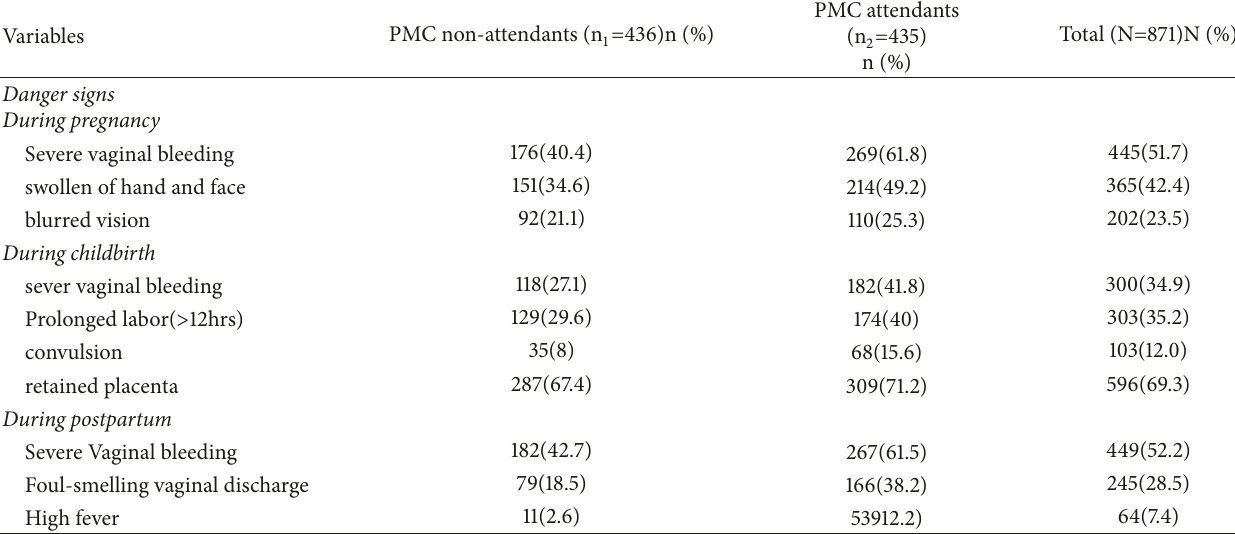
Table 3: Knowledge of obstetric key danger signs of the mothers in Libo Kemkem District, Amhara Region, North West Ethiopia,